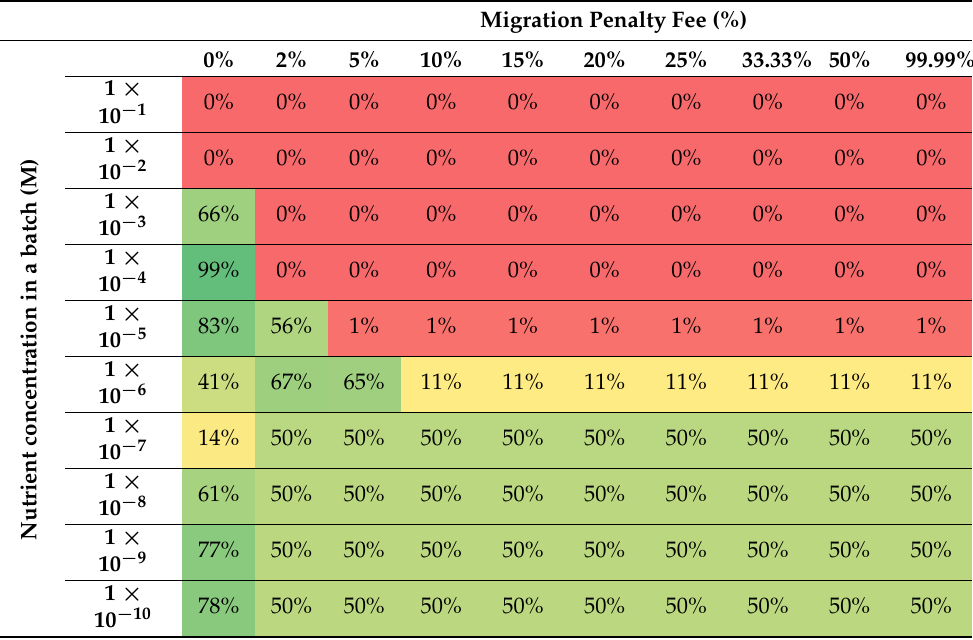
Table 3. Nomad’s abundance fraction against migration penalty fee in the environments varying by nutrient concentration in a batch from “extremely scarce” to the “rich” ones. The batch period equals 50 generations. The quadratic mortality term is used.